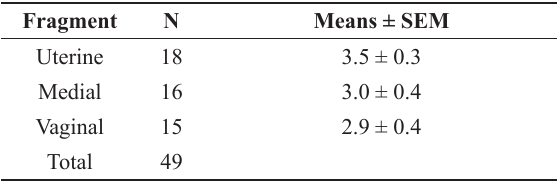
Distribution of microscopic lesions in the cervix (uterine, medial and vaginal) of heifers with GVS and presenting positive culture for Ureaplasma diversum.